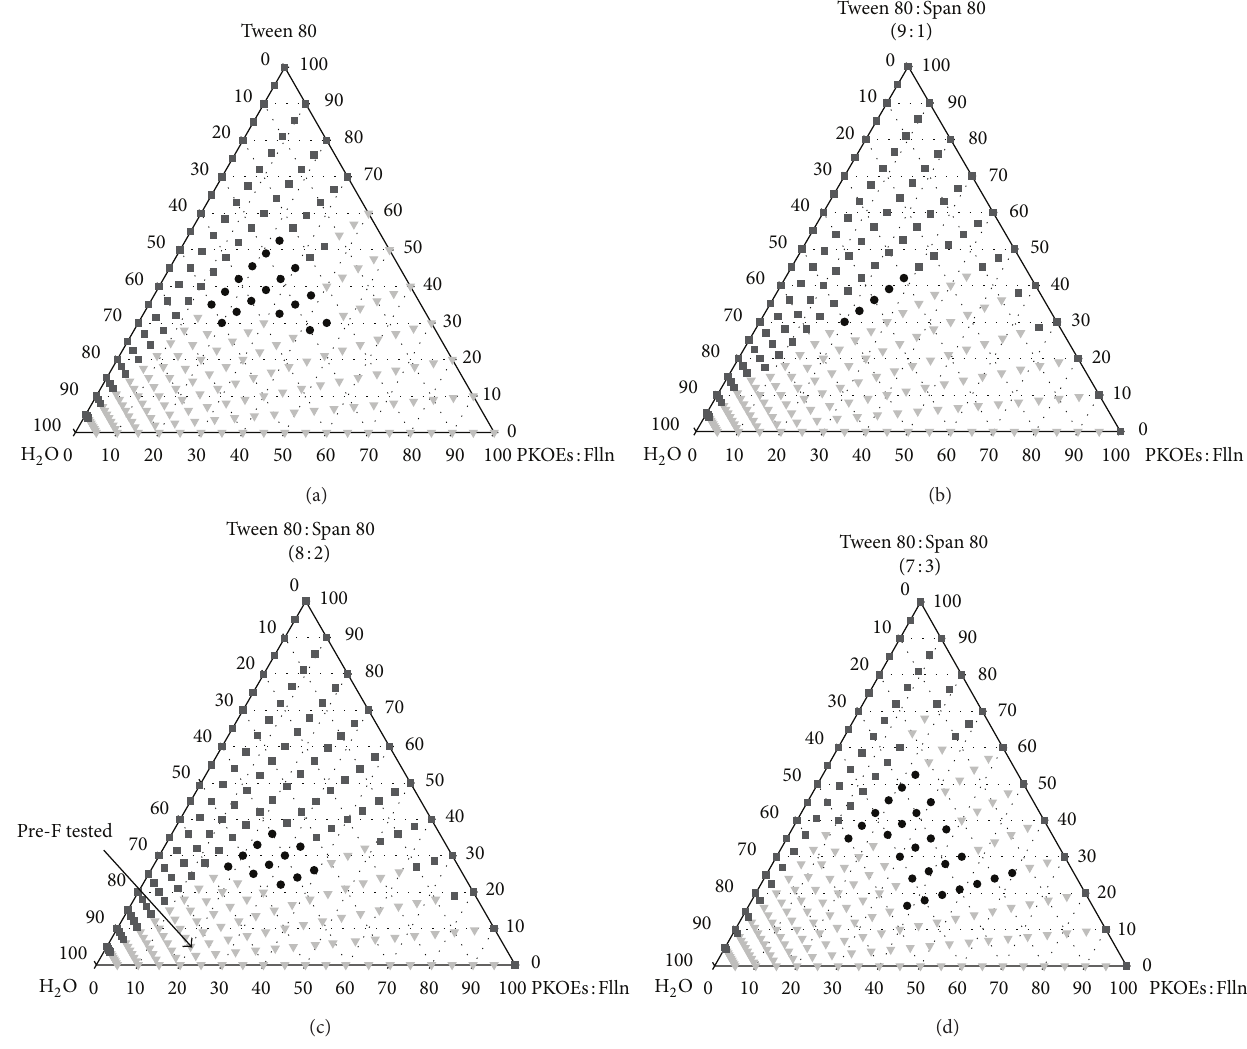
Figure 1: Pseudoternary phase diagram of PKOEs: fullerene (Flln)/Tween 80 :Span 80/Water in the MSRs of (a) 10 :0, (b) 9 :1, (c) 8: 2, and (d) 7: 3 at 298 K. ◼ = Isotropic; e = Homogeneous; 󳶃 = Two-phase.